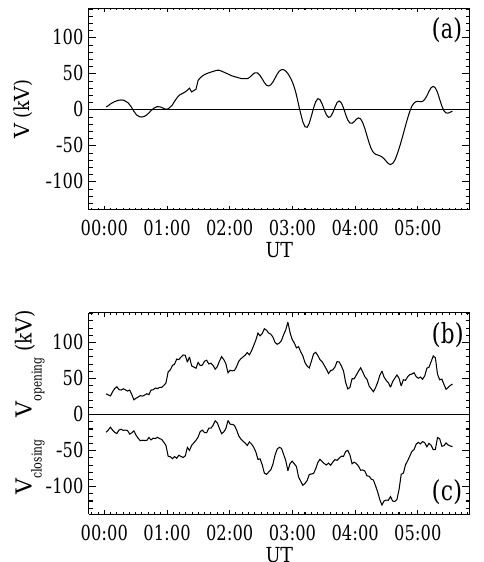
Figure 5. (a) AE, (b) AU and (c) AL indices recorded on 21 Au- gust